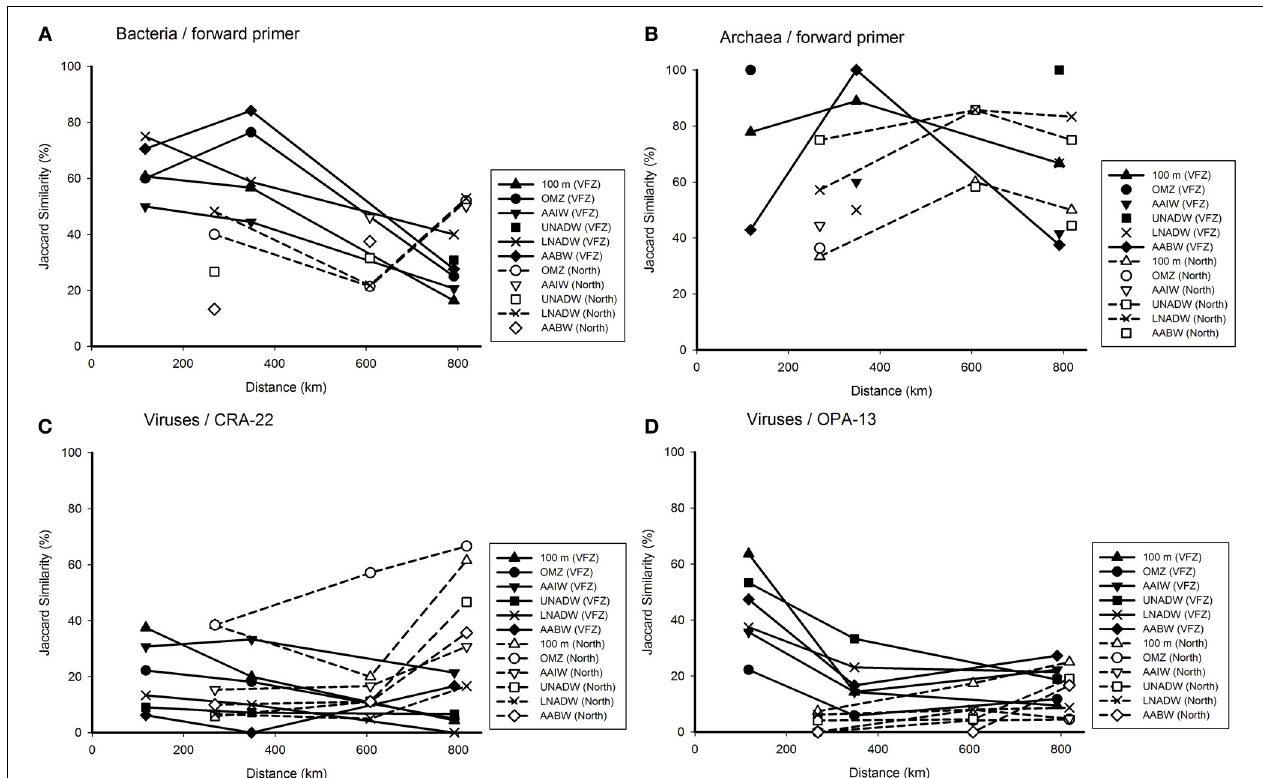
FIGURE 5 | Jaccard similarity plotted against the covered distance inside the VFZ as compared to the northern section, depicting alterations in the bacterial (A), archaeal (B), and